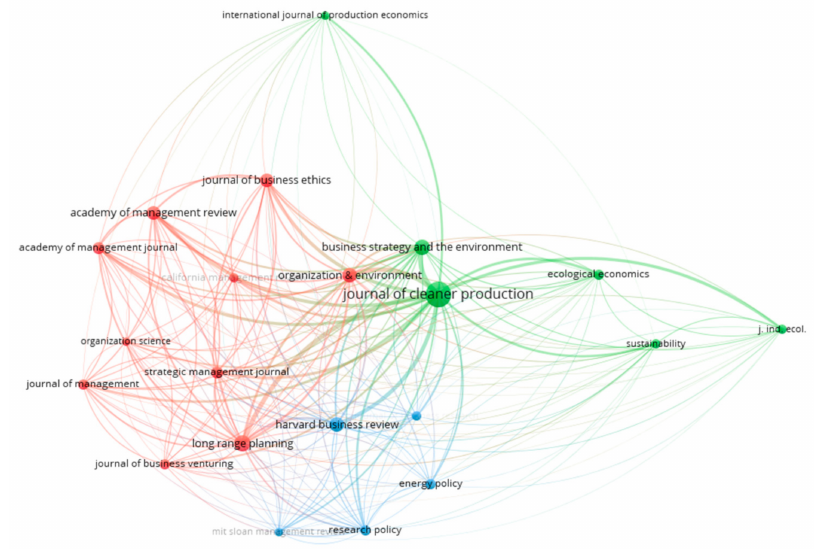
Figure 7. Co-citation of source titles cited in sustainable business models research area. Source: own elaboration based on the VOSviewer